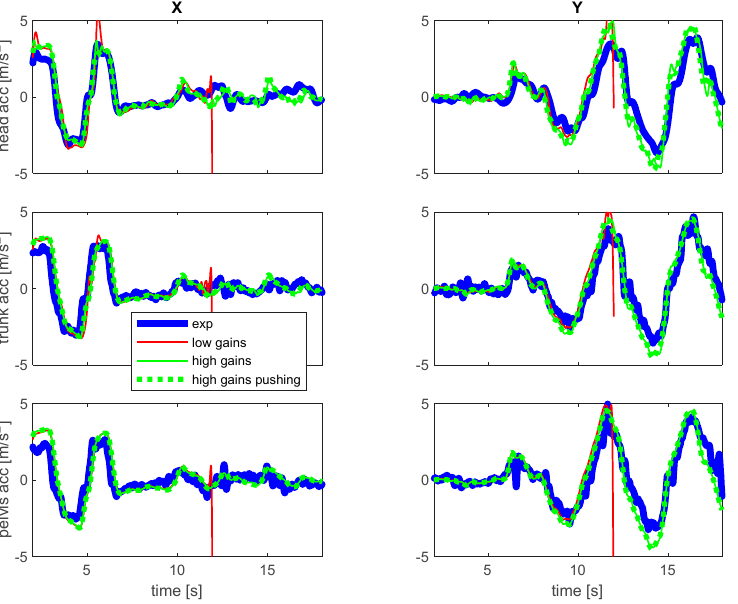
Figure 3. Slalom validation for body acceleration . Blue line: experimental; dotted green line: best model fit with high postural gains and with hips and knees pushing the body into the seat back; solid green line: high gains but no pushing; red line: lower postural gains fitted towards the vibration experiment.